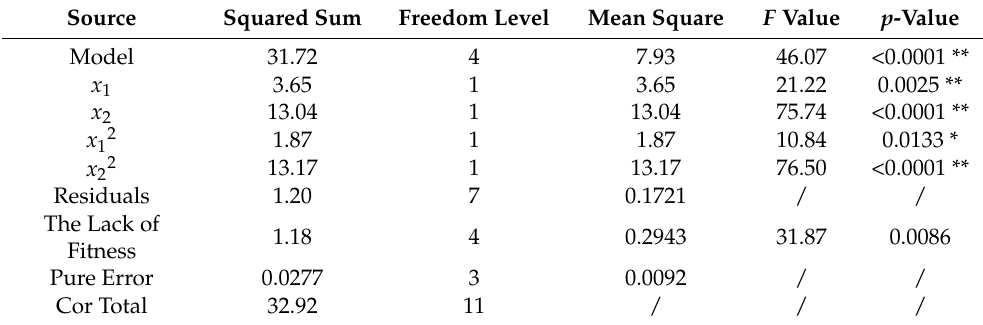
Table 6. QRSLS variance analysis.